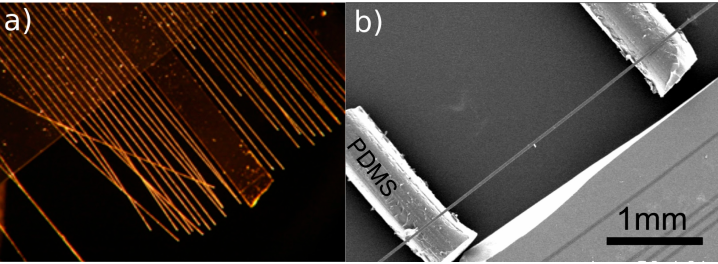
Figure 1. ( a ) Observation by optical microscope of micronic waveguiding structures after cleaving the wafer. Here, the lack of the final baking step prevents a strong adhesion between waveguide and SiO 2 /Si wafer. As a result, the structures are not cleaved together with the wafer. ( b ) SEM image of a ridge waveguide, 10 µm wide, positioned by hand on two polydimethylsiloxane (PDMS)